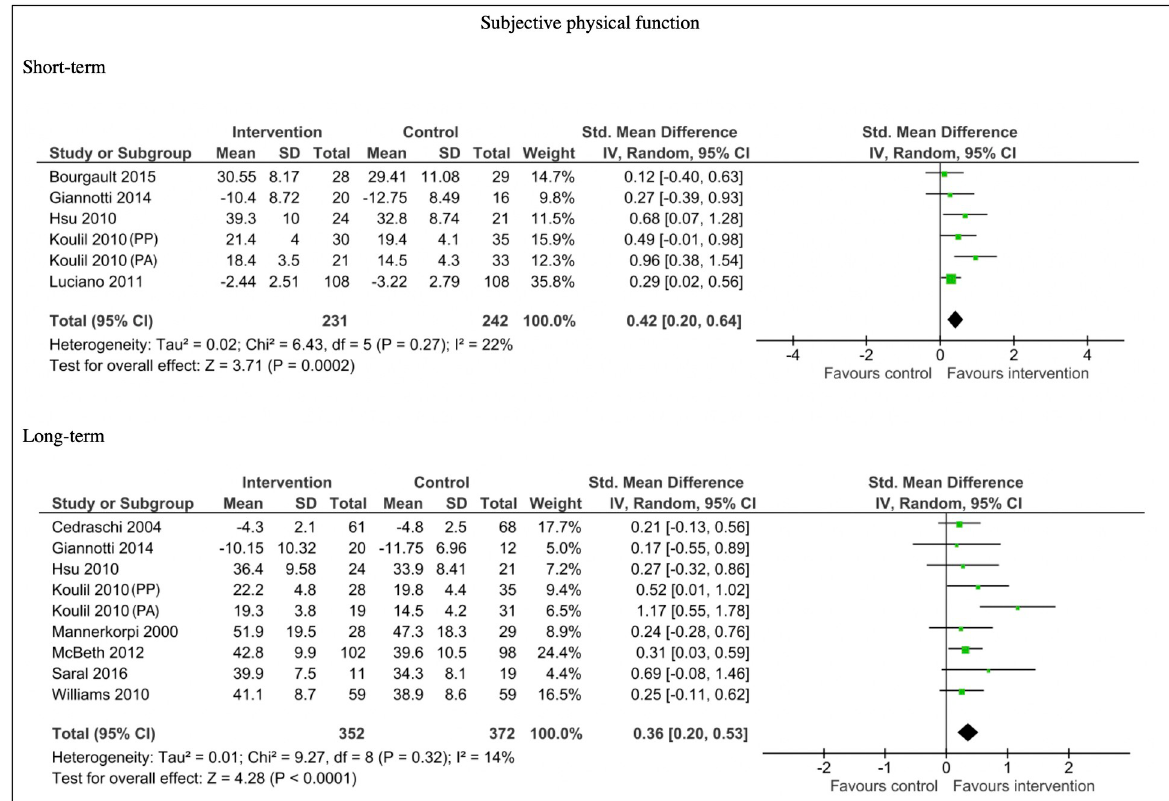
Fig 4. Forest plots of comparisons for subjective physical function for intervention compared to waitlist/no treatment/usual care controls.